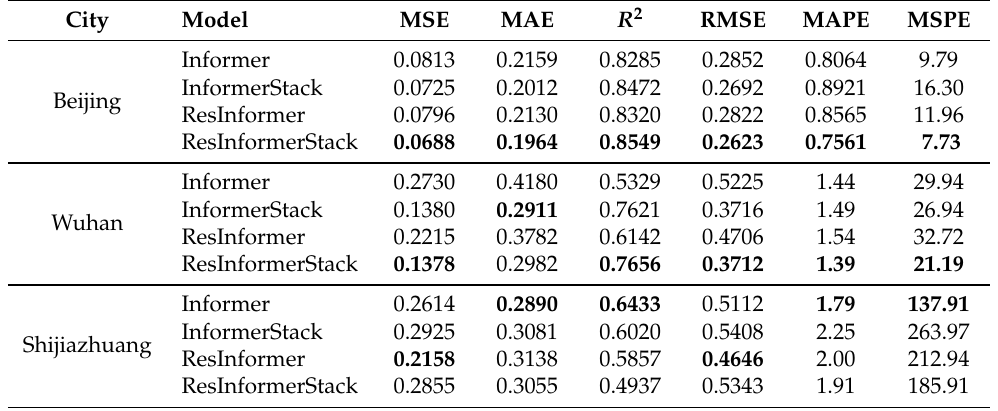
Table 2. The prediction results of